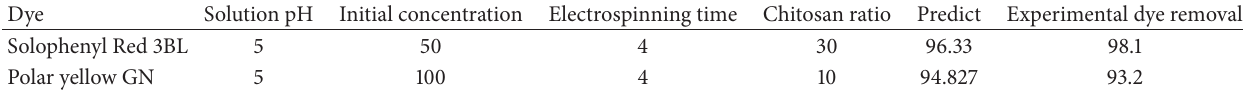
Table 5: Experimental and predicted values of dye removal for optimized condition obtained from model.